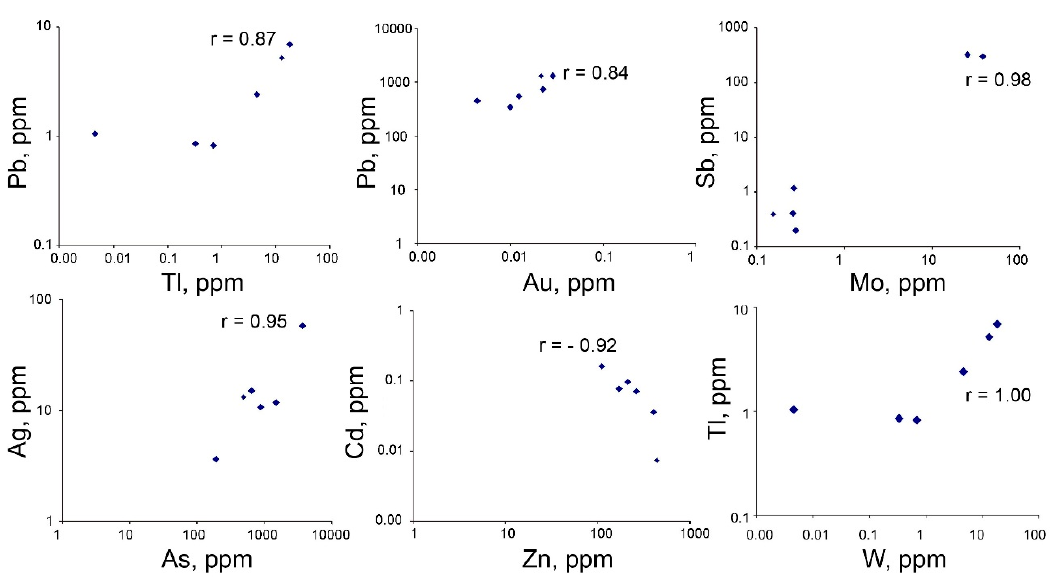
Figure 12. Log ‐ log plots for selected trace elements in reniform chalcopyrite (ppm). Figure 12. Log-log plots for selected trace elements in reniform chalcopyrite